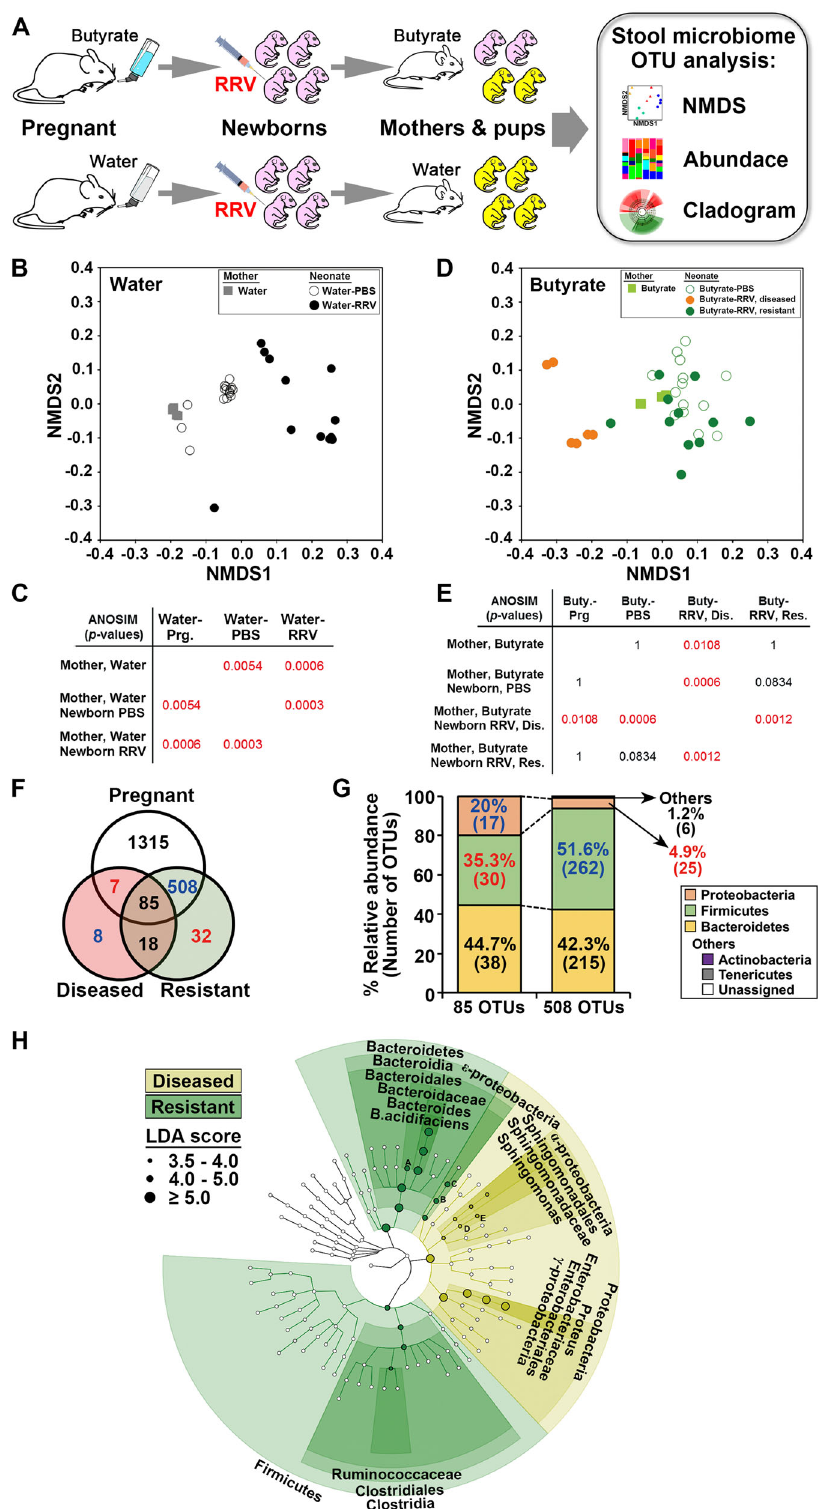
NCs (Fig. 5C and Table S4). Of the seven species enriched in NCs (Fig. S7G), Flavonifractor plautii , Hungatella hathewayi , Clos- tridium neonatale , Bacteroides dorei , and Bacteroides fragilis (Fig. S7H) showed overexpression of enzymes and genes involved in butyrate production when analyzed using BioCyc databases (Table S5). In contrast to the high concentration of